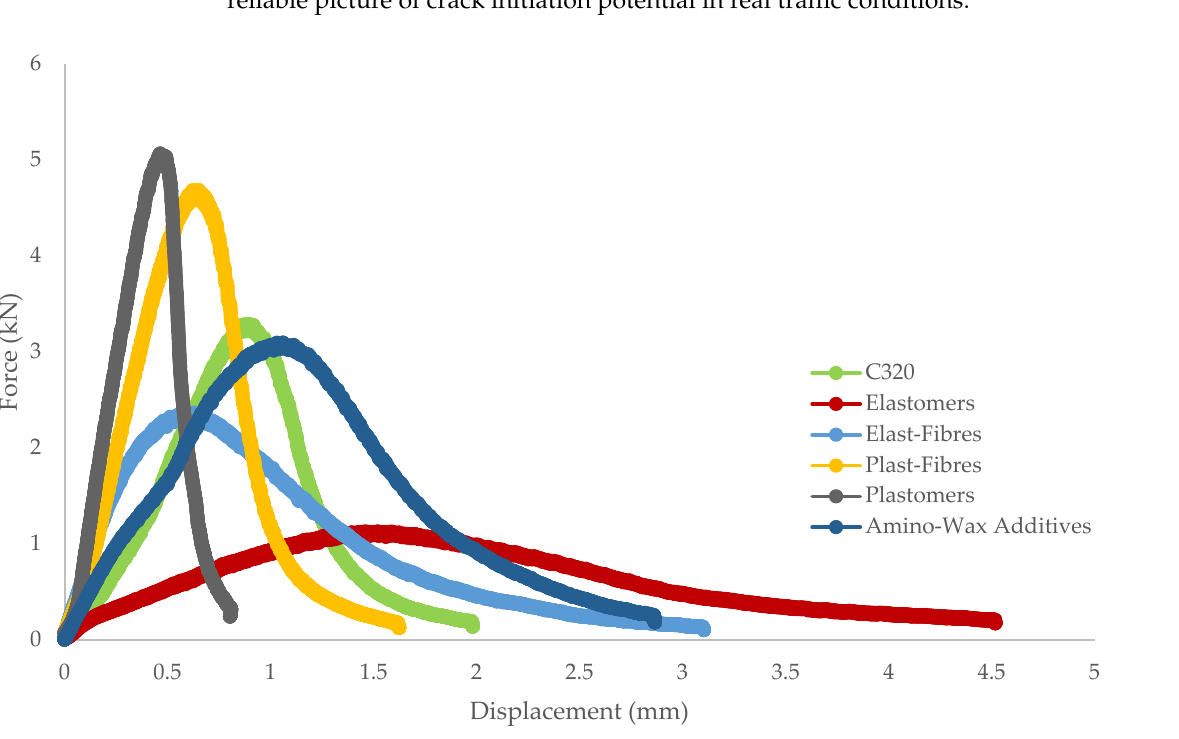
Figure 3. Typical load–displacement curves for various mixes.